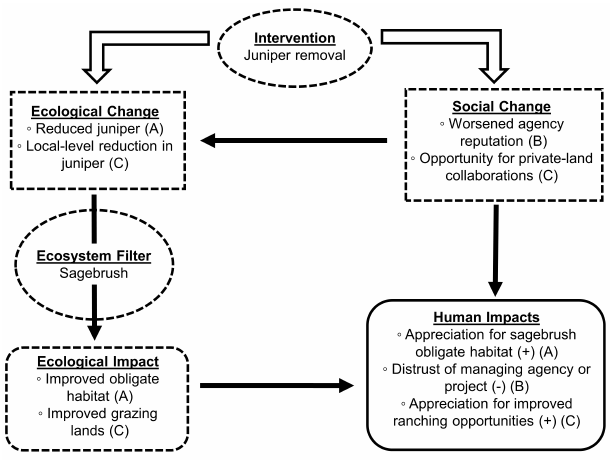
Fig. 2. Flow diagram of the social-ecological impact assessment framework (modified from Slootweg et al. 2001). The diagram begins with an intervention (i.e., juniper removal), that leads to social or ecological change through three pathways. (A) Example of the effects of reduction in juniper abundance. (B) Juniper removal influences social change when the project is perceived to be implemented poorly, thus degrading an agency’s reputation and causing a negative (−) human impact in terms of public distrust of the management agency. (C) Juniper removal influences social change by providing an opportunity for public agency collaborations with private landowners, resulting in additional local-level juniper removal. This ecological change is perceived to improve grazing lands. Thus, for those who appreciate improved ranching opportunities, the human impact via this last pathway is positive (+). All arrows represent pathways to human